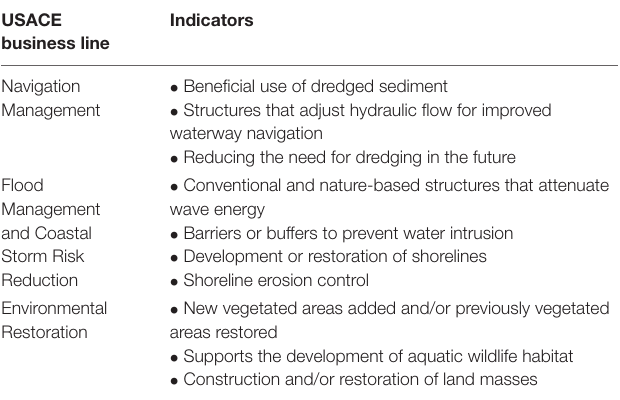
TABLE 2 | USACE business line